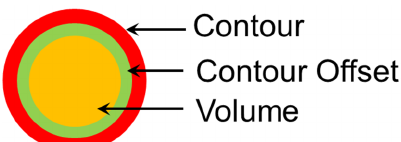
Figure 12. Schematic illustrating the different zones identified in an SLM part: contour, contour offset and actual volume of the part.